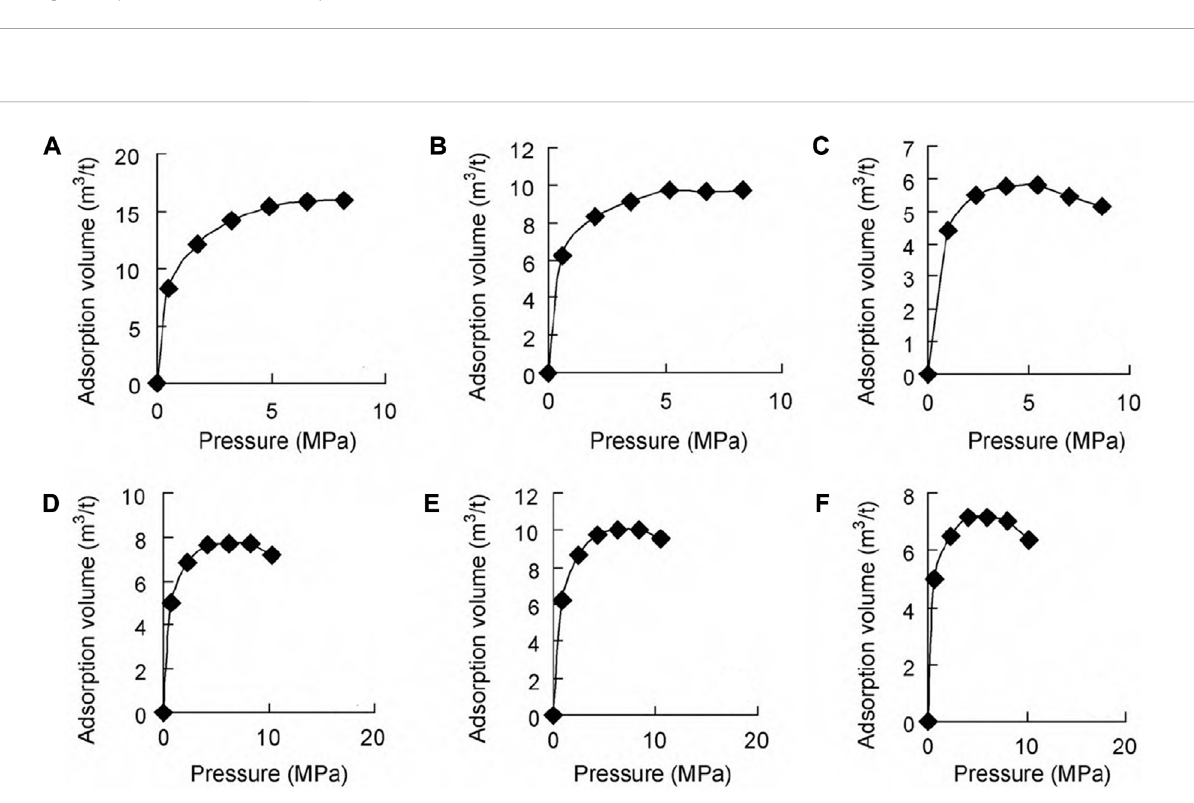
FIGURE 2 Isothermal adsorption curves of tectonic coals and untectonic coal. (A) Untectonic coal; (B) cataclastic structure coal; (C) schistose structure coalinbrittledeformationcoals; (D) schistose-wrinkle structurecoal inbrittle-ductile superimposedcoals; (E) scaledstructurecoal inbrittle-ductile deformation coals; (F) mylonitic structure coal in ductile deformation coals. (Ju and Li, 2009, reprinted with permission of the copyright